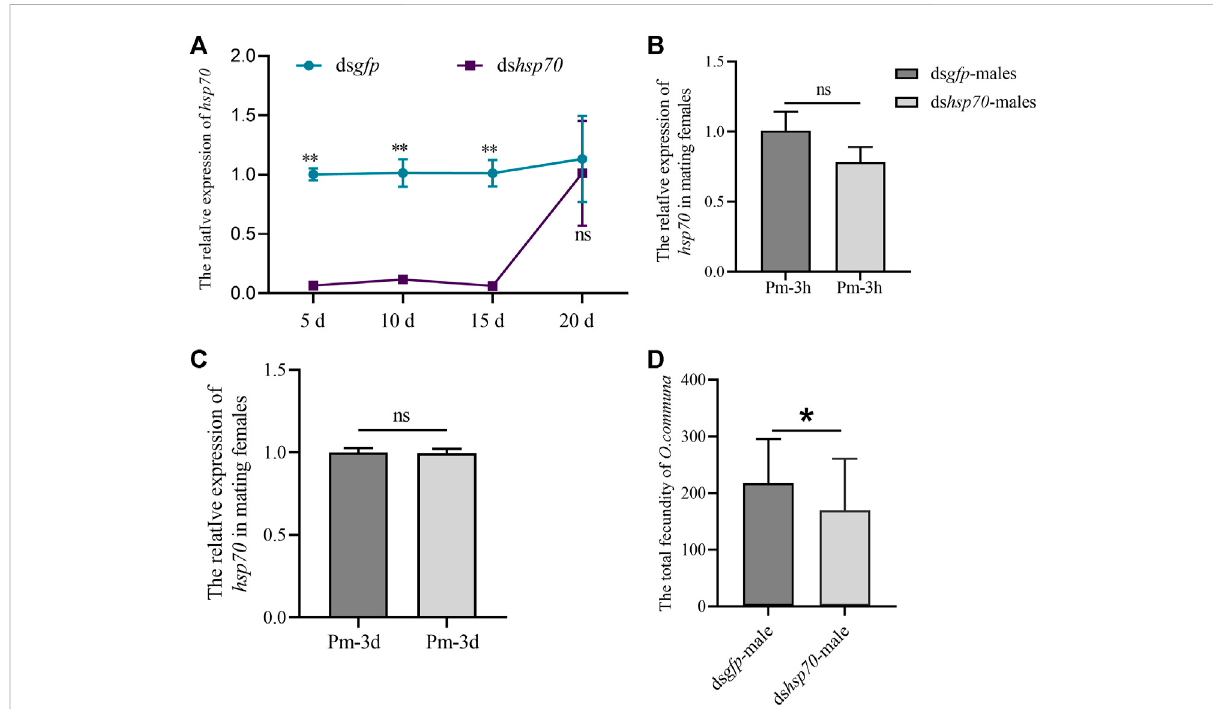
FIGURE 2 Functional characterization of Ochsp70 and evaluation of RNA silencing ef fi ciency in males. (A) Expression levels of Ochsp70 (5, 10, 15, and 20 d)afterdsRNAwasinjectedintothemales. (B) Expressionlevelsof Ochsp70 inthereproductivesystemoffemalescopulatedwithdsRNA-injected males, 3 h post-mating (Pm-3h). (C) Expression levels of Ochsp70 in the reproductive system of females copulated with dsRNA-injected males, 3 d post-mating(Pm-3d). (D) Effect of Ochsp70 on O.communa fecundity.Bars with thesameletterare not signi fi cantly different fromeach other at p < 0.05, as per the LSD test.